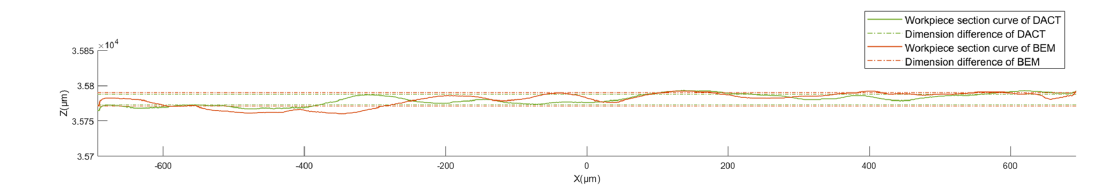
Figure 28. Workpiece surface topography machined by BEM with inclination angle of approximately 20°.